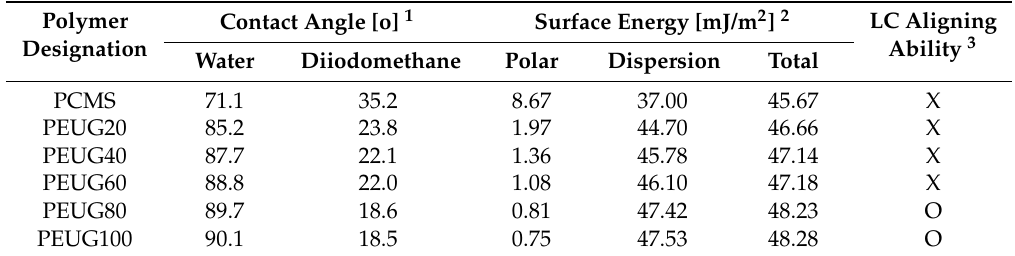
Table 2. Contact angle and surface energy values and LC orientation properties on the polymer films.